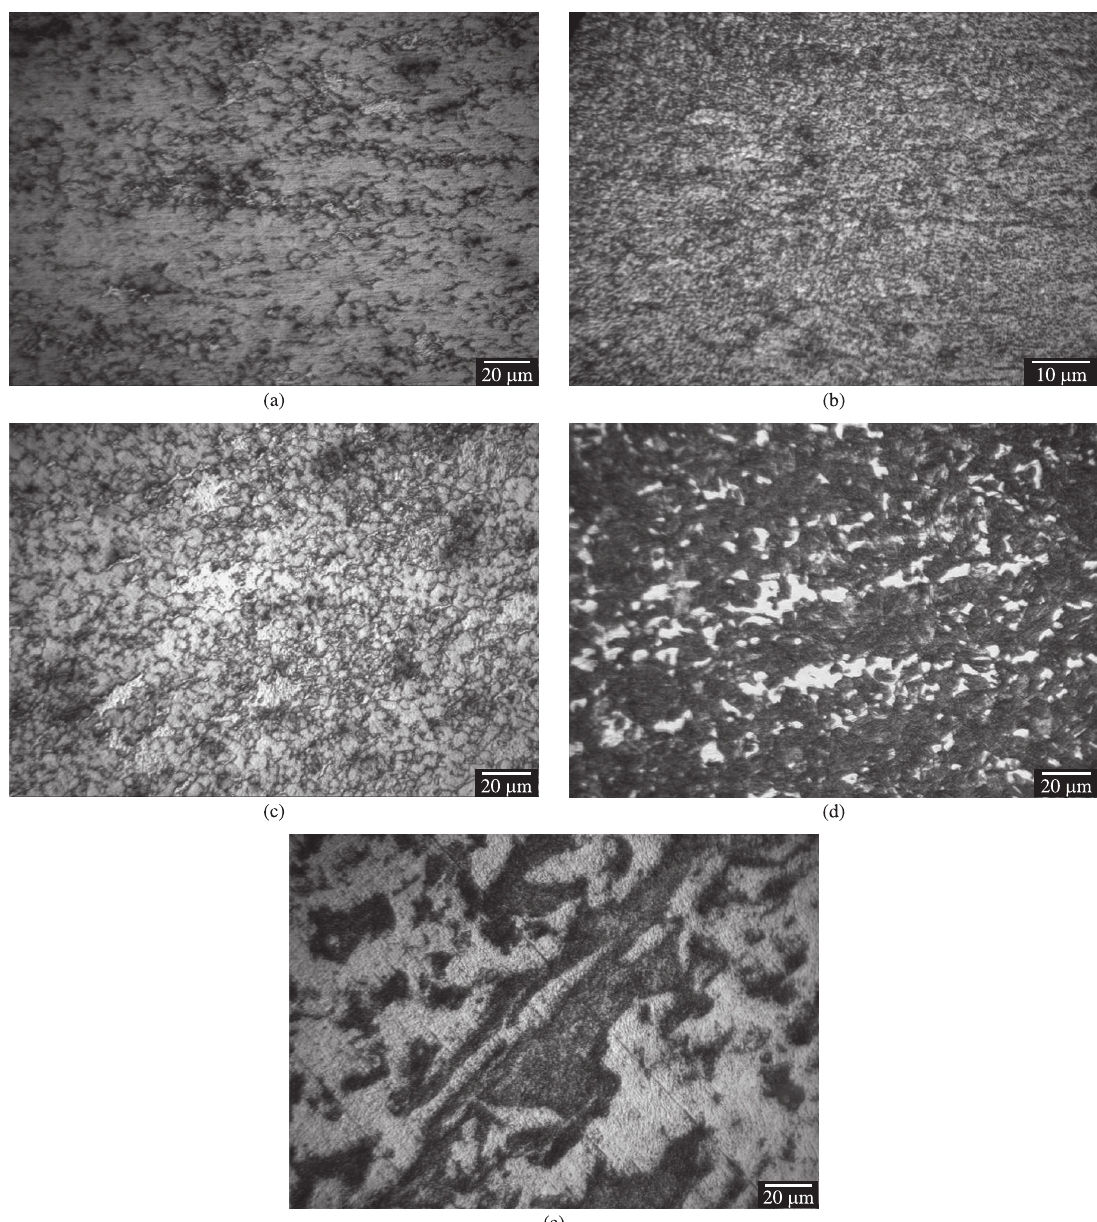
Figure 1. a) As-deformed structure of M500 showing conspicuous deformation bands revealing the direction of cold rolling; b) M500 structure after 1 minute of treatment at 740 °C. The structure reveals fine precipitation of cementite; c): M500 structure after 15 minutes of treatment at 740 °C. The structure reveals coarse cementite particles and some recrystallization nuclei; d) M500 structure after 30minutes of treatment at 740 °C. The structure consists of ferrite (white phase) and martensite (dark phase); and e) M500 structure after 1hour of treatment at 740 °C. The structure consists of large dispersed phase of martensite (dark phase) in continuous phase of ferrite (gray